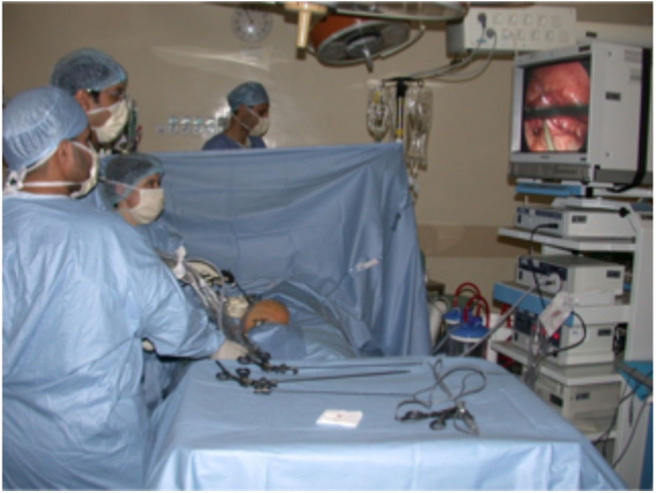
Position of the surgeon and all assistants.